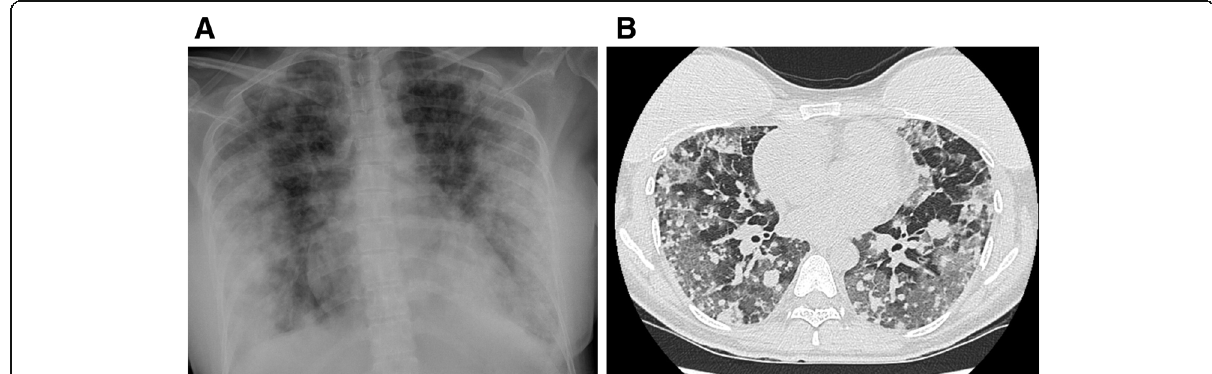
Fig. 1 a Scout Image from Chest CT, revealing diffuse ground-glass opacification and pulmonary infiltrates. b Contrast-enhanced chest CT, presenting signs of diffuse alveolar hemorrhage and multiple pulmonary nodules